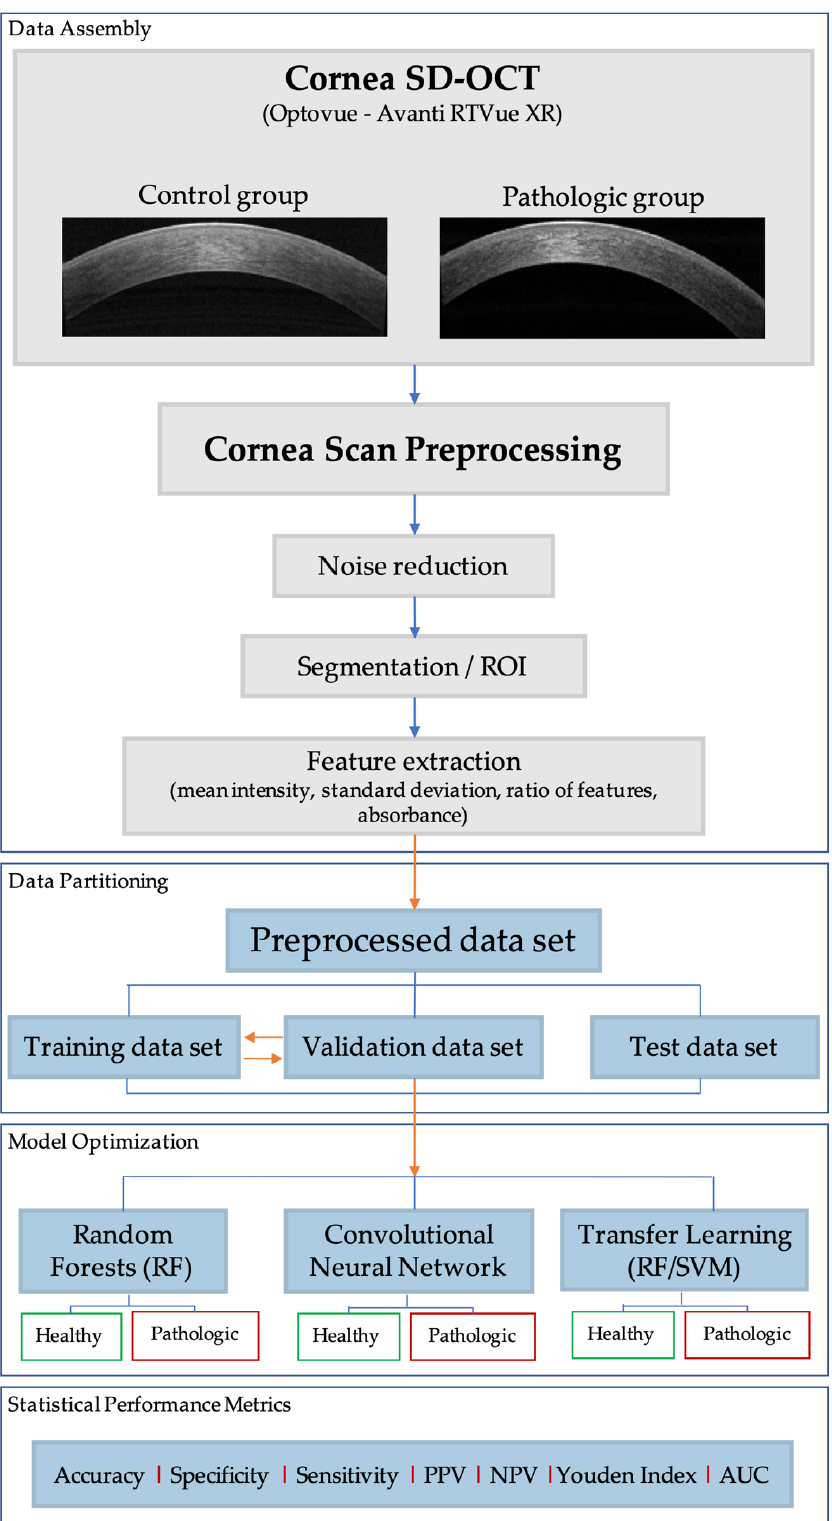
Figure 1. Workflow diagram of the research methodology. Spectral-domain optical coherence tomography (SD-OCT), region of interest (ROI), random forest (RF), support vector machine (SVM), positive predictive value (PPV), NPV: negative predictive value (NPV) and area under the curve (AUC). (C) Segmentation and Feature Extraction.